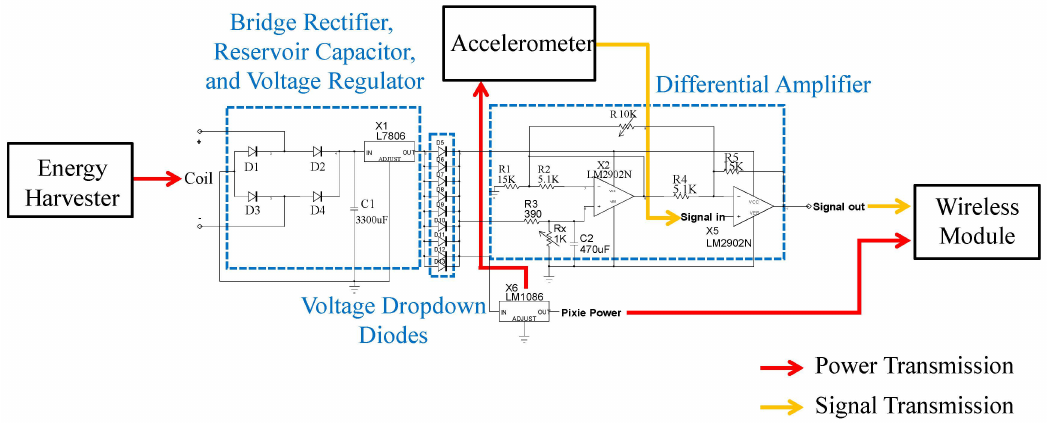
Figure 4. Circuit diagram of the rectification